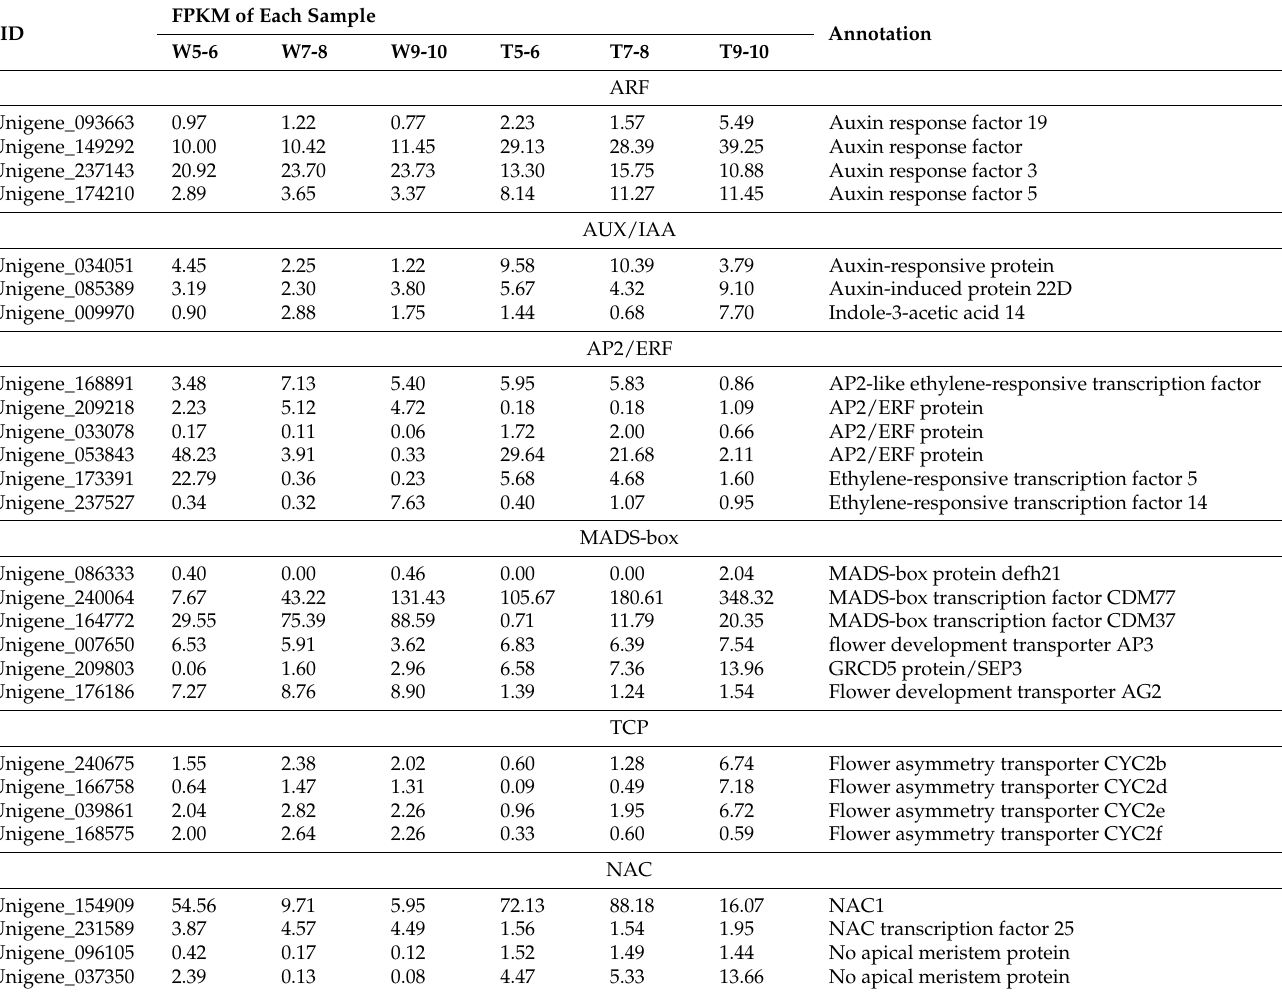
Table 1. Candidate genes regulating the formation of different ray floret